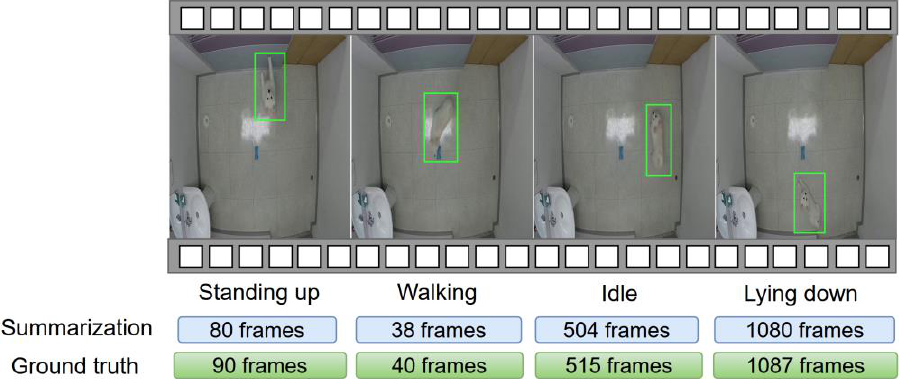
Figure 6. Behavior-based video summarization results on video containing different dog behaviors.